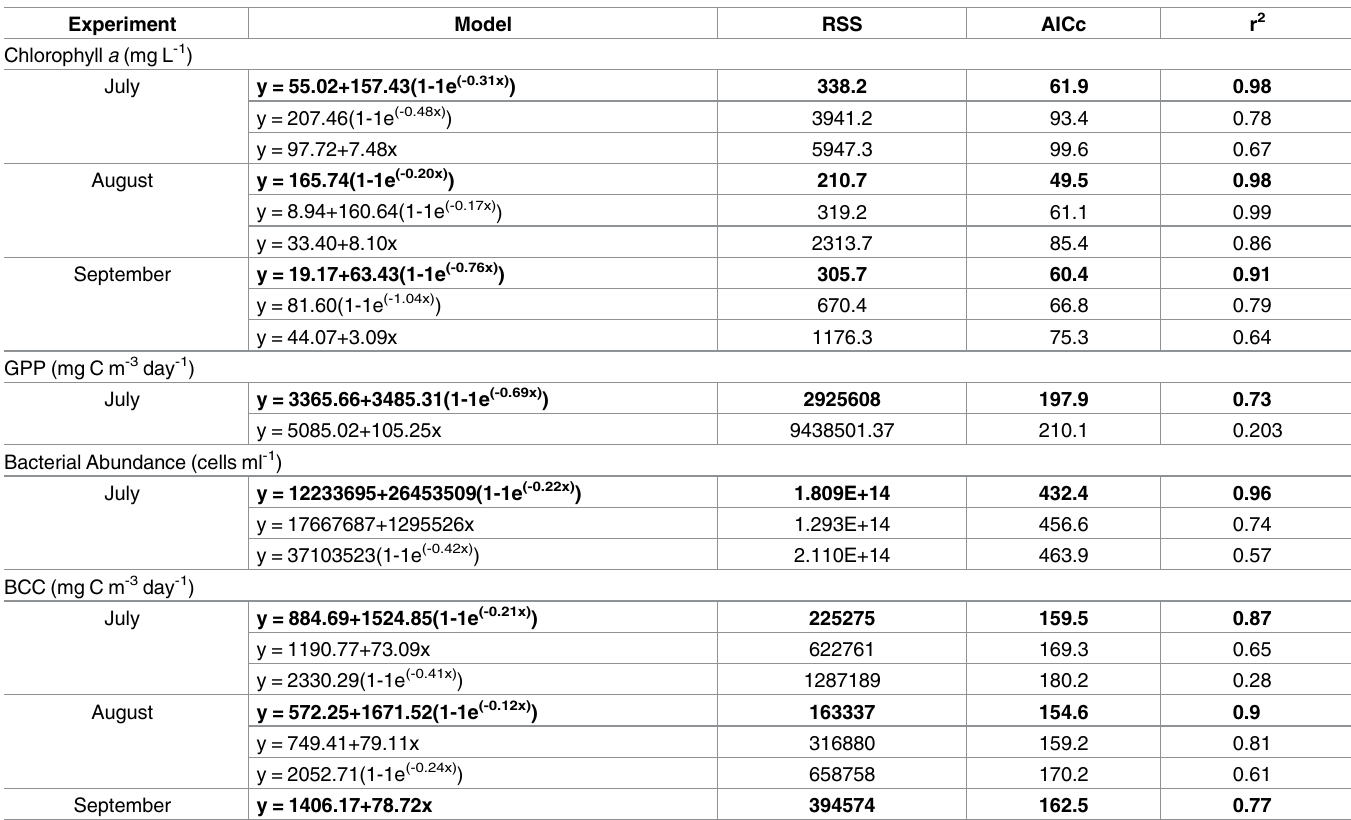
Table 1. Model fits describing N effect on mesocosm plankton dynamics. Least squaresregressionanalysis( n = 15) of phytoplankton and bacterial abundance and production(y) as functions of urea load (x). Models were selectedusing Akaike information criterion corrected for small sample sizes (AIC c ), and rankedbasedon AIC c score, with best-fitting modelsin bold. Modelswith no explanatorypower(i.e. r 2 = 0) are omitted. See Fig 2 for graphical representa- tion of best-fit models.